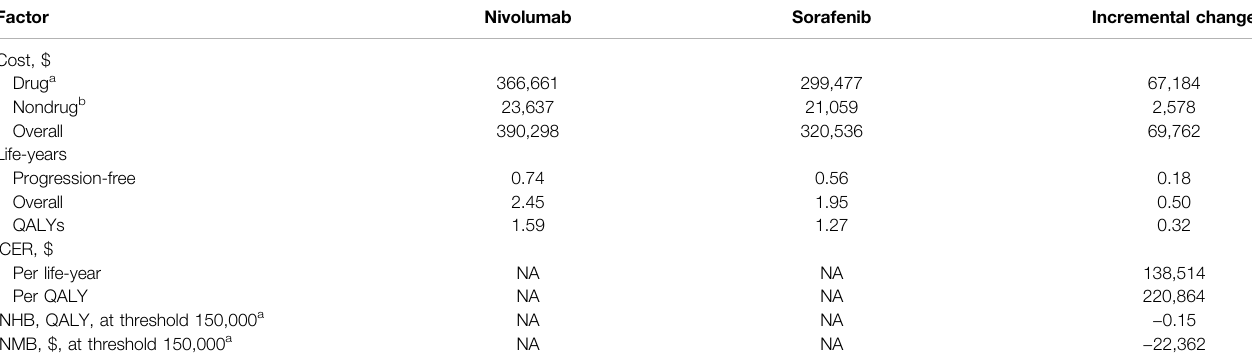
TABLE 2 | Summary of cost and outcome results in the base-case analysis. Factor